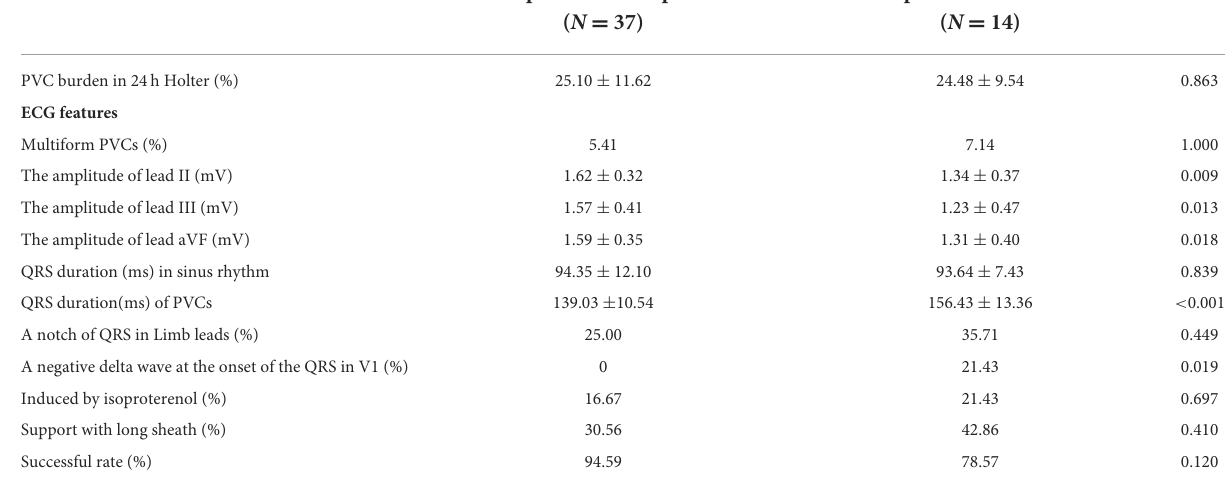
TABLE 2 Electrocardiographic characteristics of PVCs originating in the anterior septum in the superior RVOT group and in the inferior RVOT group. Anterior septum of the superior RVOT Anterior septum of the inferior